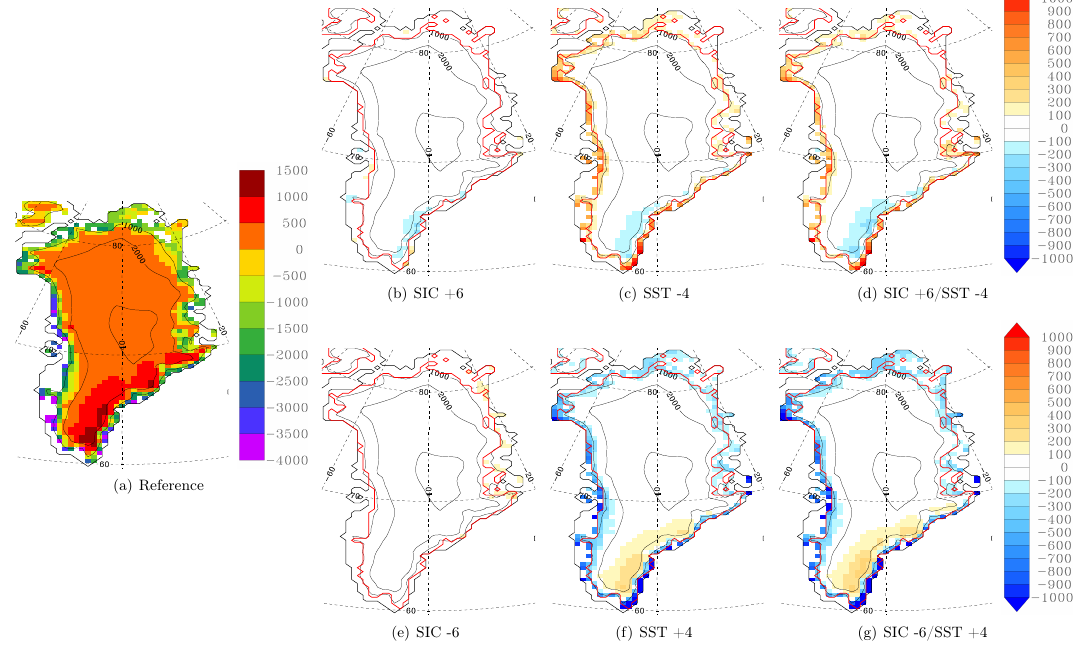
Figure 5. Annual mean cumulated SMB (mmWE yr − 1 ) for the reference run (a) , using the MAR model (2007–2012). Difference in the annual mean cumulated SMB (mmWE yr − 1 ) between (b) SIC + 6, (c) SST − 4, (d) SIC + 6/SST − 4, (e) SIC − 6, (f) SST + 4, (g) SIC − 6/SST + 4 experiments and the reference run. The thick red line defines the GrIS area in MAR.